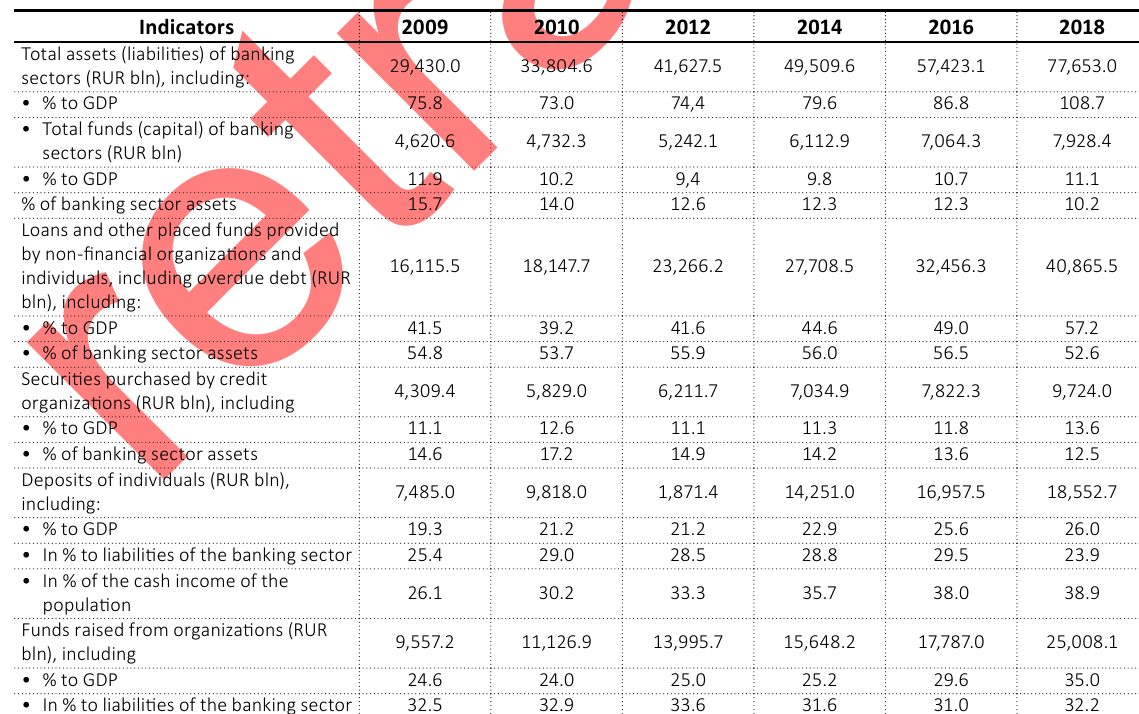
Source: Author’s calculations, Thomson